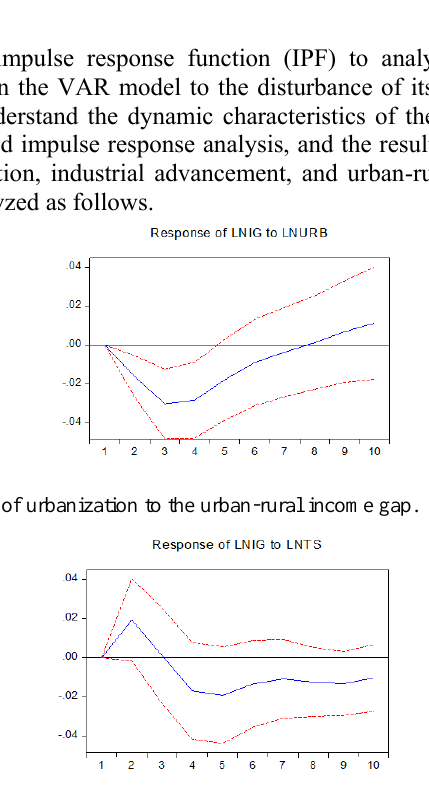
Fig. 2. The response path of industrial advancement to the urban-rural income